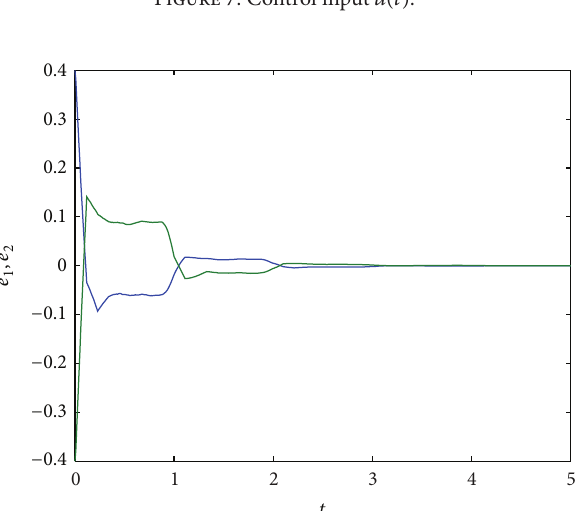
Figure 6: Chaotic behavior of slave system (13) with 𝑢(𝑡) = 0 .